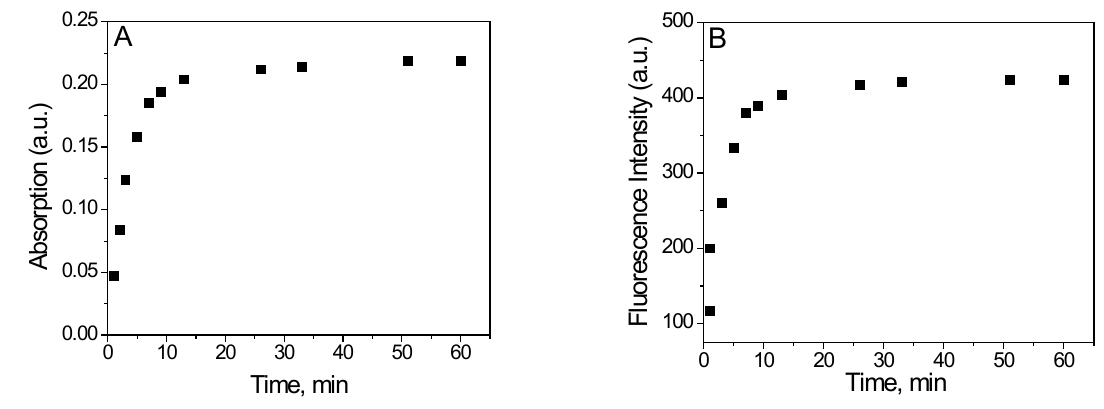
Figure 4: Absorption (A) and fluorescence (B) release profile of E from cotton matrix in aqueous solution at pH = 7.2 at 25 o C for 60